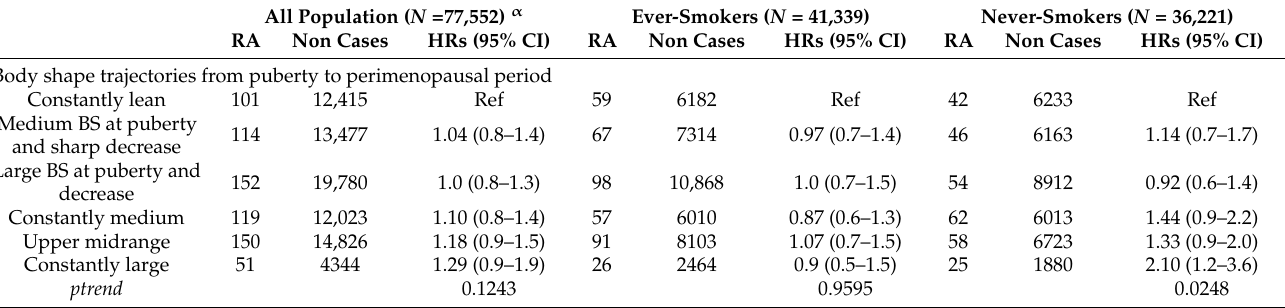
Table 3. Hazard ratios (95% confidence intervals) for the risk of RA by body shape trajectories in multi-adjusted model (for the overall population, ever-smokers and never-smokers).